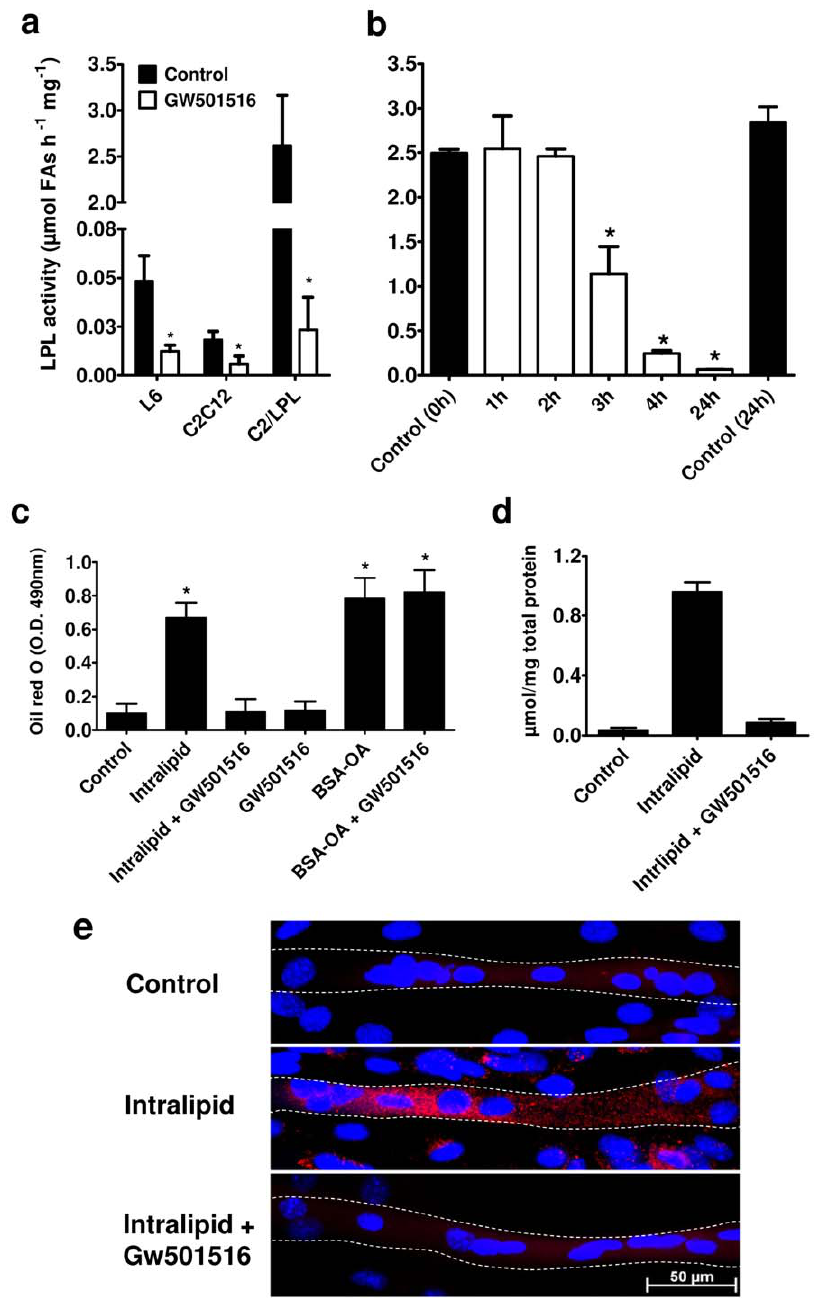
Figure 4. PPAR d activation by GW501516 inhibits LPL activity and LPL-dependent fatty acid uptake. ( a ) Heparin releasable LPL activity was measured in the L6, C2C12 and C2/LPL myotubes after 24 hour incubation of the cells in the presence of GW501516, n=3. ( b ) Time dependent inhibition of LPL activity by GW501516 (0.1 m M) was measured in heparin releasable pool from C2/LPL myotubes, n=3. ( c ) Oil Red O staining of myotubes was quantified by densitometry in cells incubated with Intralipid or OA-BSA for 5 hours in the presence or absence of GW501516, n=4. ( d ) Intracellular triglycerides quantification in cells incubated with Intralipid for 5 hours in the presence or absence of GW501516, n=3 ( e ) Fluorescence microscope images of C2/LPL myotubes (highlighted with a line) incubated with Intralipid for 5 hours in the presence or absence of GW501516. Nuclei are stained in blue (DAPI) and lipid droplets in red (Oil Red O). * p , 0.05, paired t test ( a ) or One-way ANOVA with Dunnett’s post test ( b, c, d ) compared with